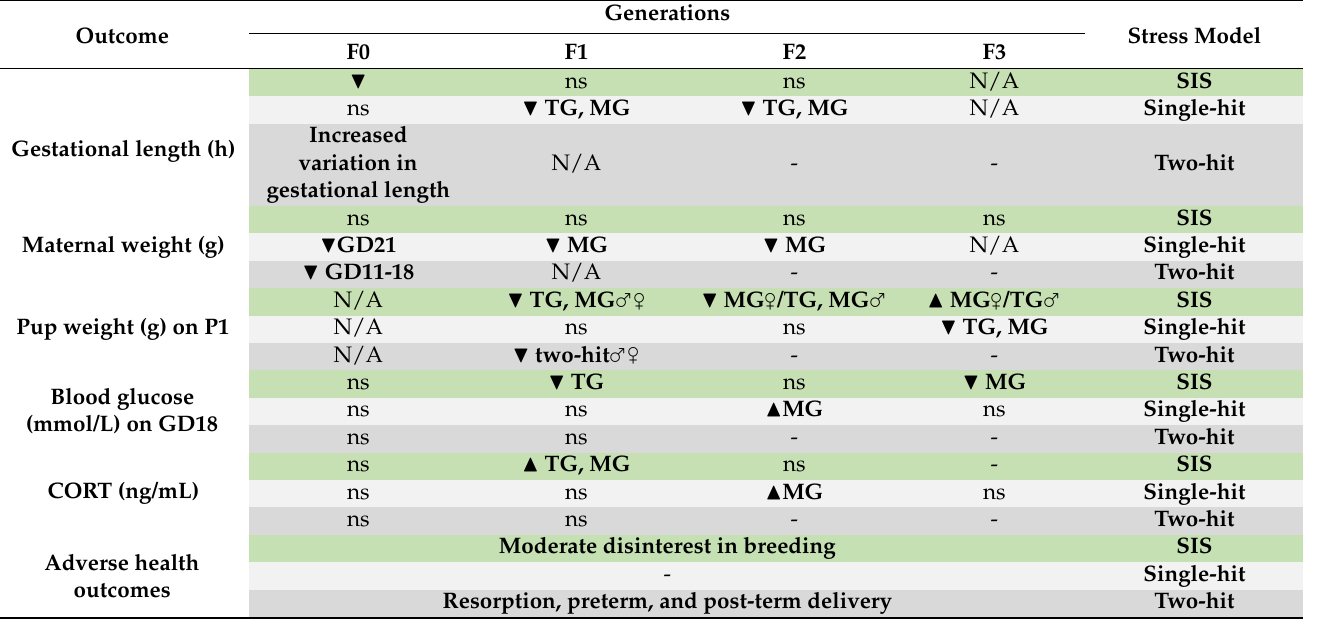
Table A1. Health outcomes comparison between three types of prenatal maternal stress models